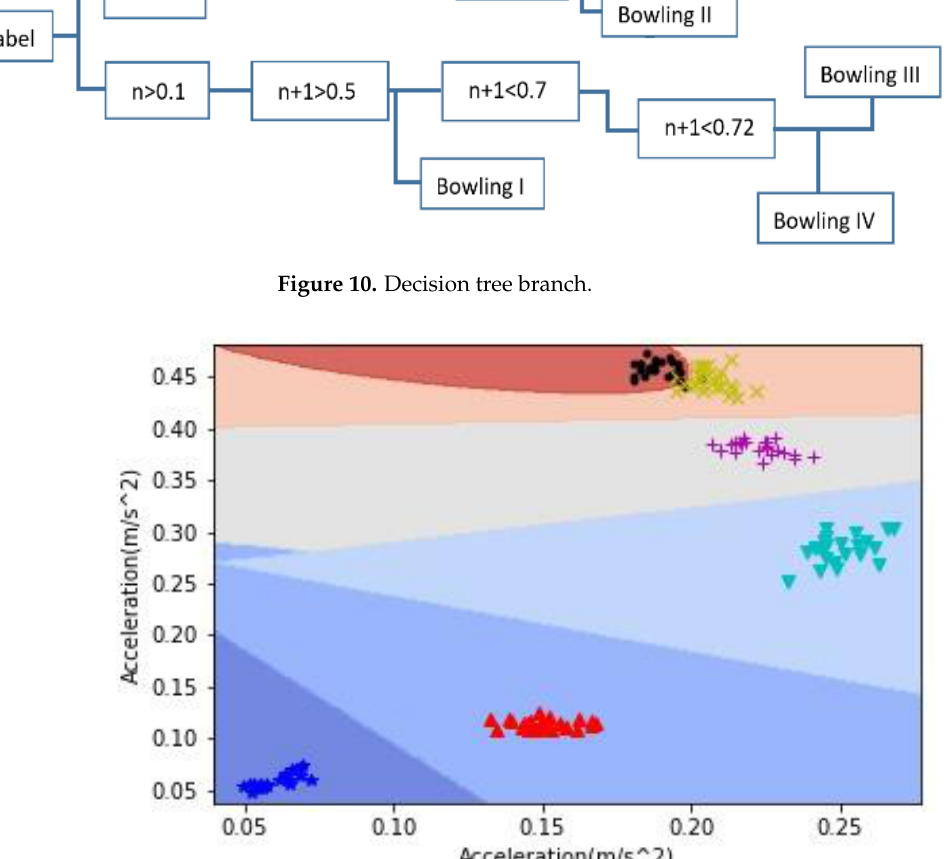
Figure 11. Support Vector Machine (SVM) Eigenspace. Table 7. All classifier